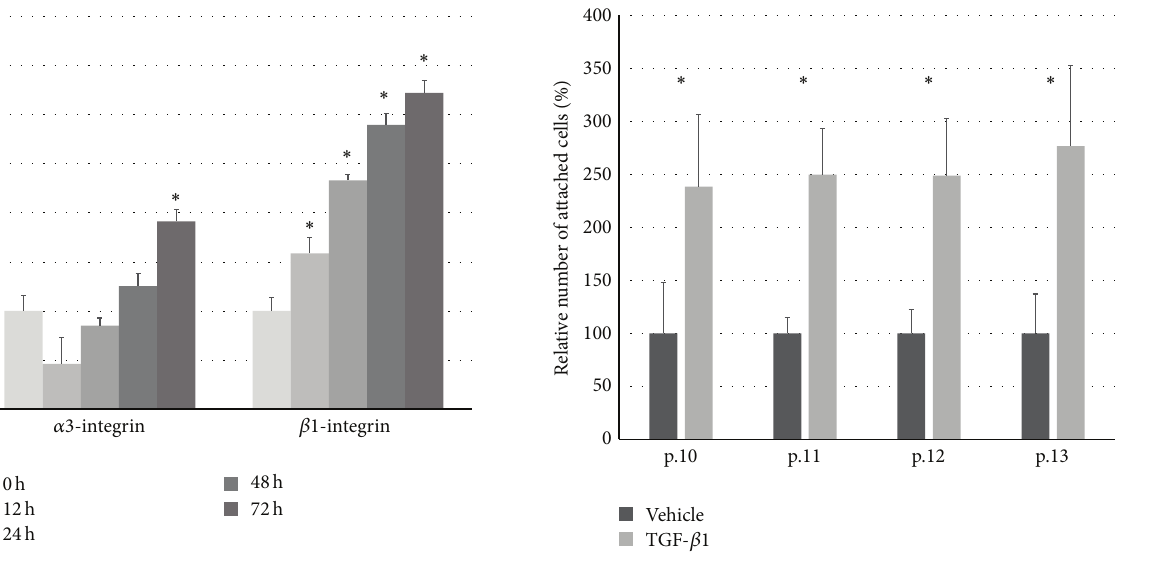
Figure 4: Attachment assay of HSMP cultured with/without TGF- 𝛽 1. Attachment assay was performed as described in Methods using cells of passages 10–13. The 𝑦 -axis shows percentage of attached HSMP cultured with TGF- 𝛽 1 relative to that of HSMP cultured with the vehicle. ∗ 𝑝 < 0.05 versus vehicle.